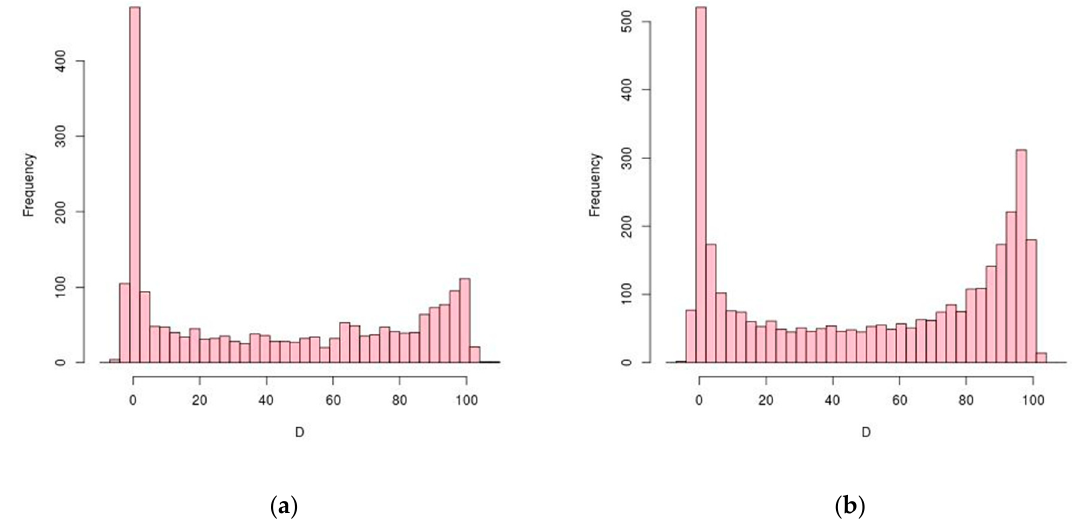
Figure 1. Distribution of CDS length-normalized positions ( D ) of TPS (transcriptional processing sites). Processing sites at start and stop codons are D = 0 and D = 100, respectively. Histograms have size 3 bins. ( a ) H. salinarum NRC-1; ( b ) H. volcanii DS2.